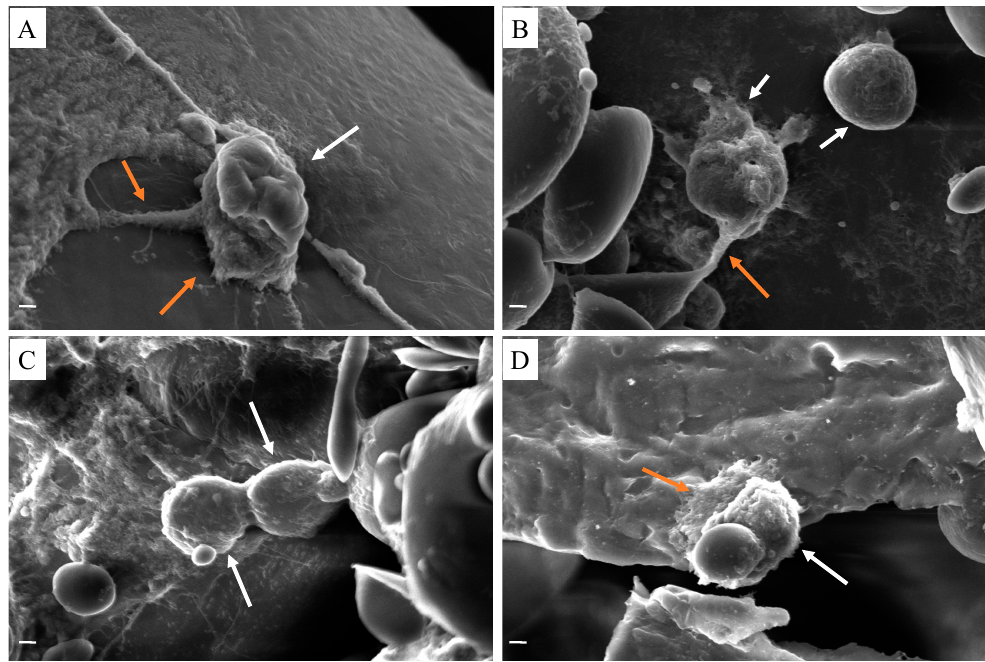
Figure 6. SEM images of human osteoblast cells (white arrow) and pseudopodia-like extended morphology (orange arrow) on ( A ) PCL/GEL, ( B ) PCL/GEL/BC, ( C ) PCL/GEL/BC/0.25%HA, ( D )